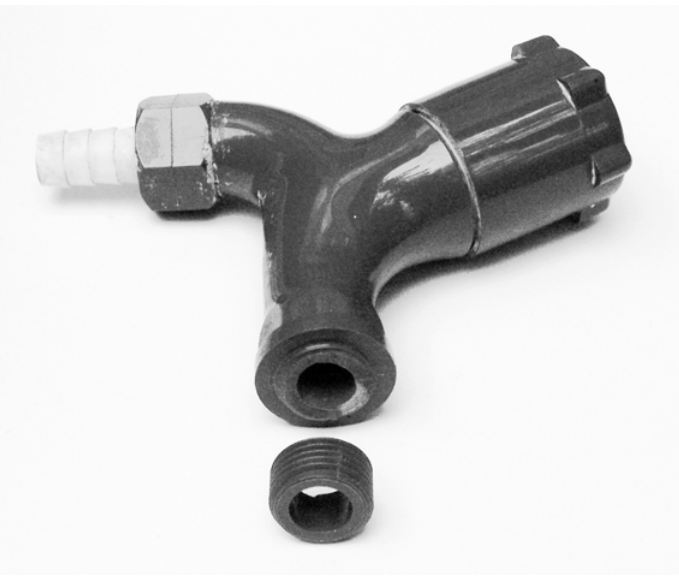
Figure 7. Plastic domestic